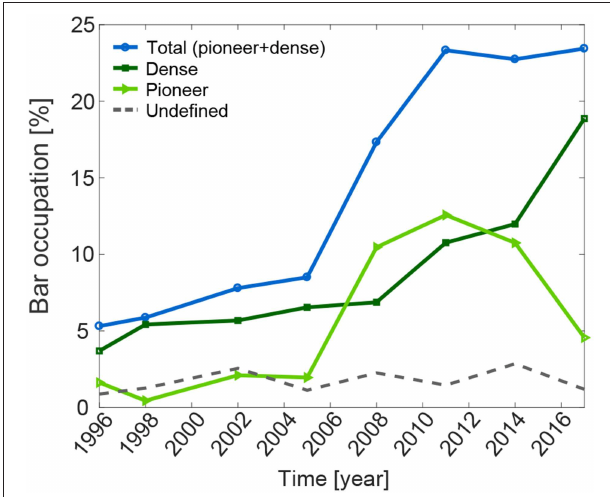
FIGURE 4 | Temporal evolution of vegetation bar occupation as a proportion of the total bar area. Three classes are represented: pioneer and dense vegetation, and undefined